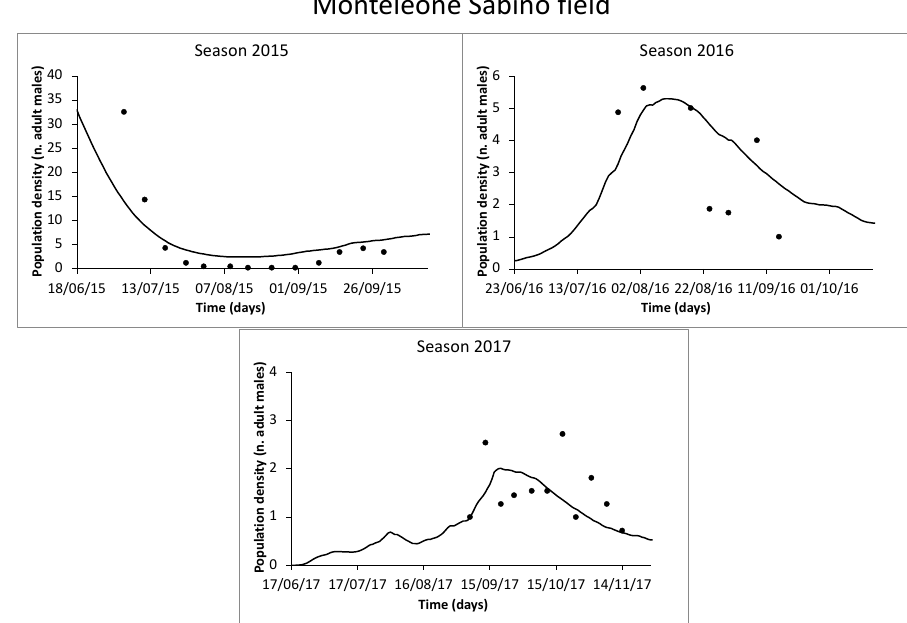
Figure 5. Comparison between simulations and experimental data collected in the Monteleone Sabino area. Dots express field population samplings (mean value provided by three traps), while continuous lines are the simulations carried out through model (3). Additional information about model validation is listed in Table 4.